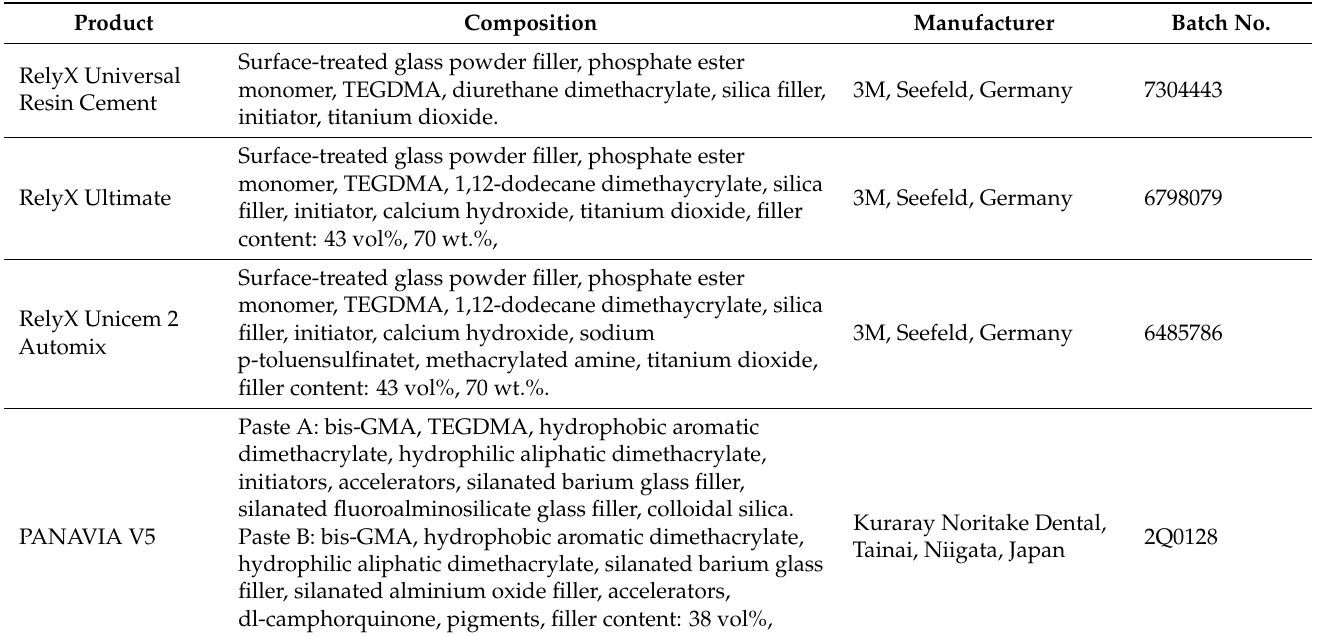
Table 1. Luting agent materials